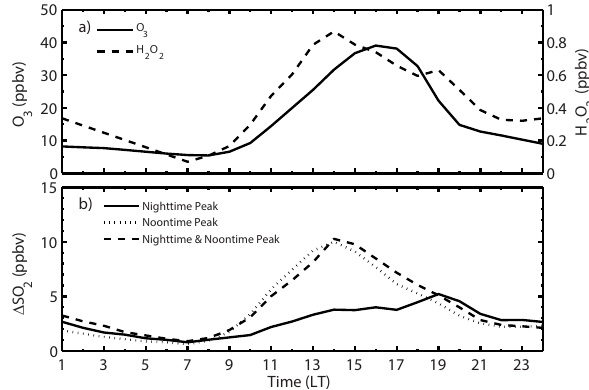
Figure 8. (a) O 3 and H 2 O 2 diurnal profiles used in the estimations; (b) Estimated aqueous phase oxidized SO 2 amount based on the three characteristic SO 2 diurnal variation patterns in Wuqing during autumn